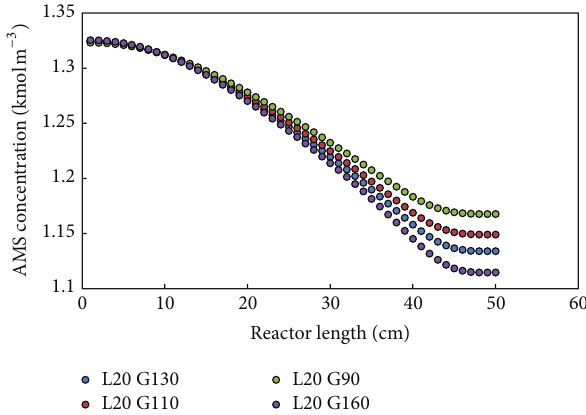
Figure 3: Calculated concentrations of AMS along reactor length for a liquid flow rate of 20 mL min −1 and various gas flow rates.